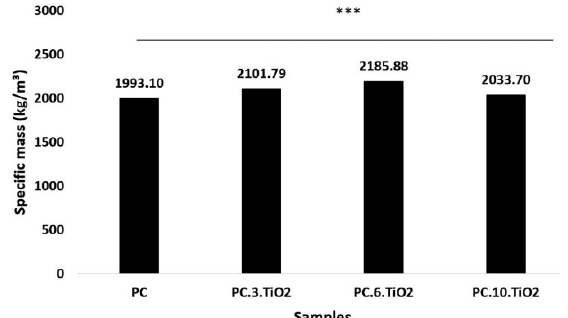
Figure 11 Average samples results of specific mass tests. *** Statistically significant difference by the Tukey test p <0.001.